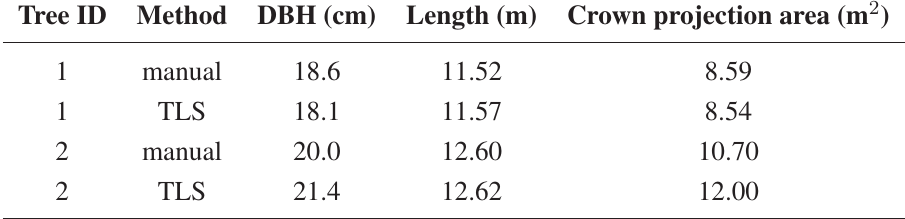
Table 5. Comparison of manual ground truth data with the TLS-derived results.